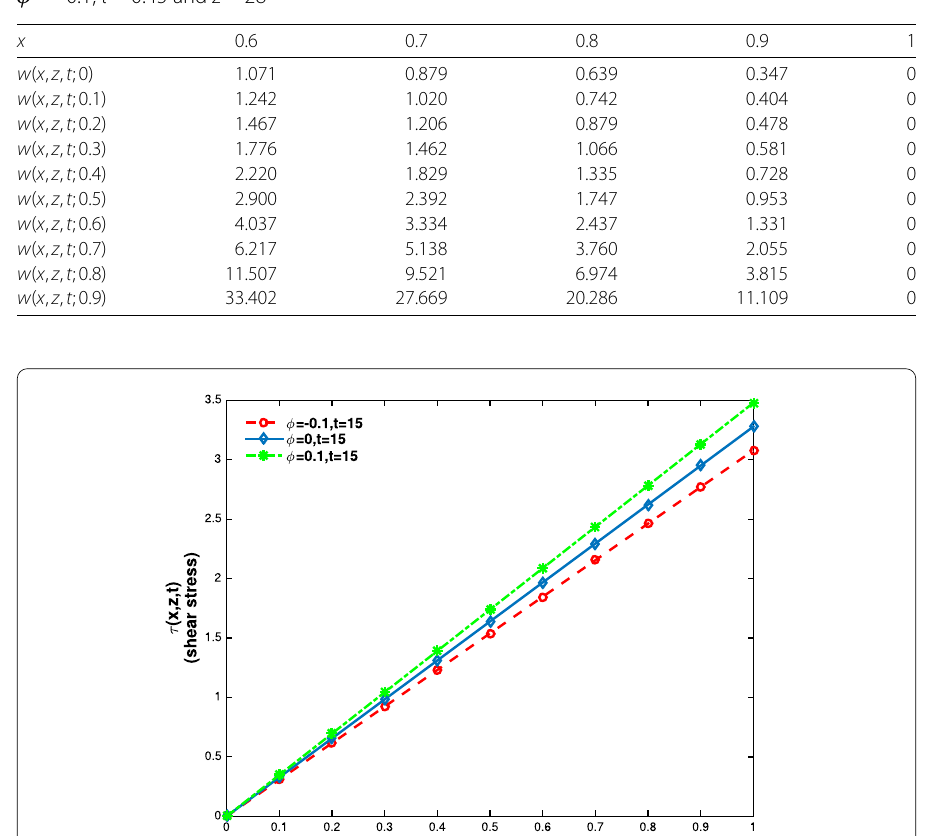
Table 1 Values of axial velocity w ( x , z , t ; λ ) resulting from Eq. (25) corresponding to λ -values for φ = –0.1, t = 0.45 and z = 28